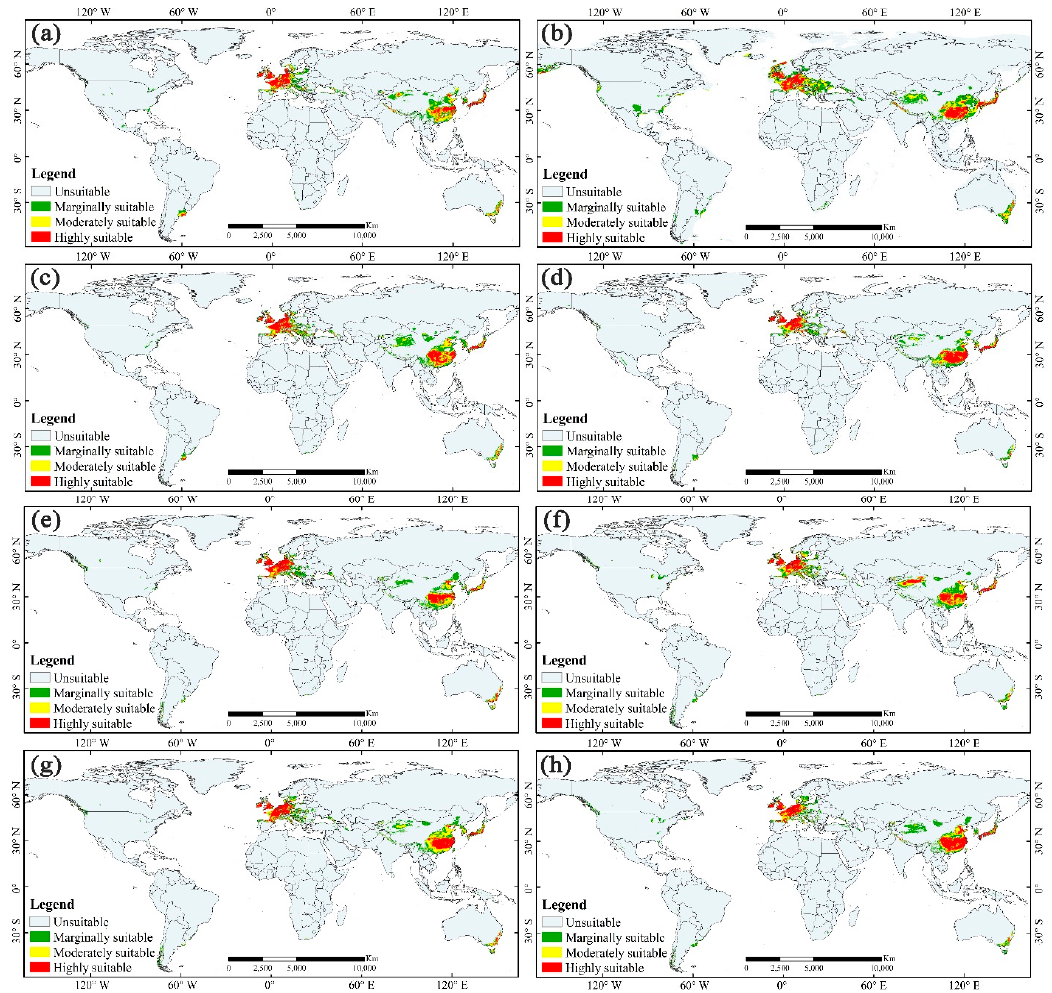
Figure 4. Potential distribution of M. glyptostroboides under each climate scenario. The green, yellow, and red represent the marginally suitable, moderately suitable, and highly suitable areas, respectively: ( a ) in the LIG, ( b ) in the LGM, ( c ) in the MH, ( d ) in the current period, ( e ) under RCP4.5 in the 2050s, ( f ) under RCP8.5 in the 2050s, ( g ) under RCP4.5 in the 2070s, and ( h ) under RCP8.5 in the 2070s.